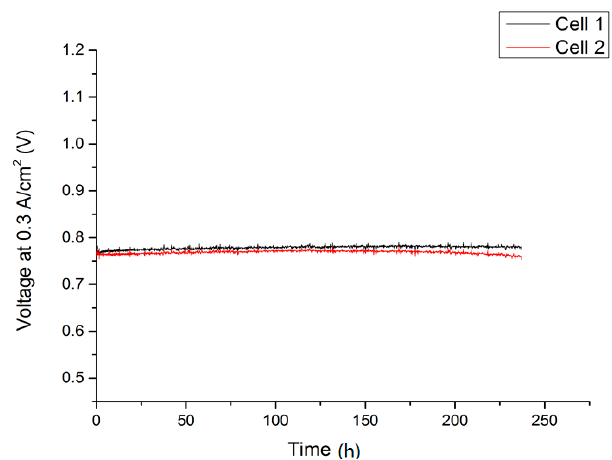
Figure 2. Performance of two metal-supported cells operated in a lightweight stack at 750 °C under galvanostatic conditions.